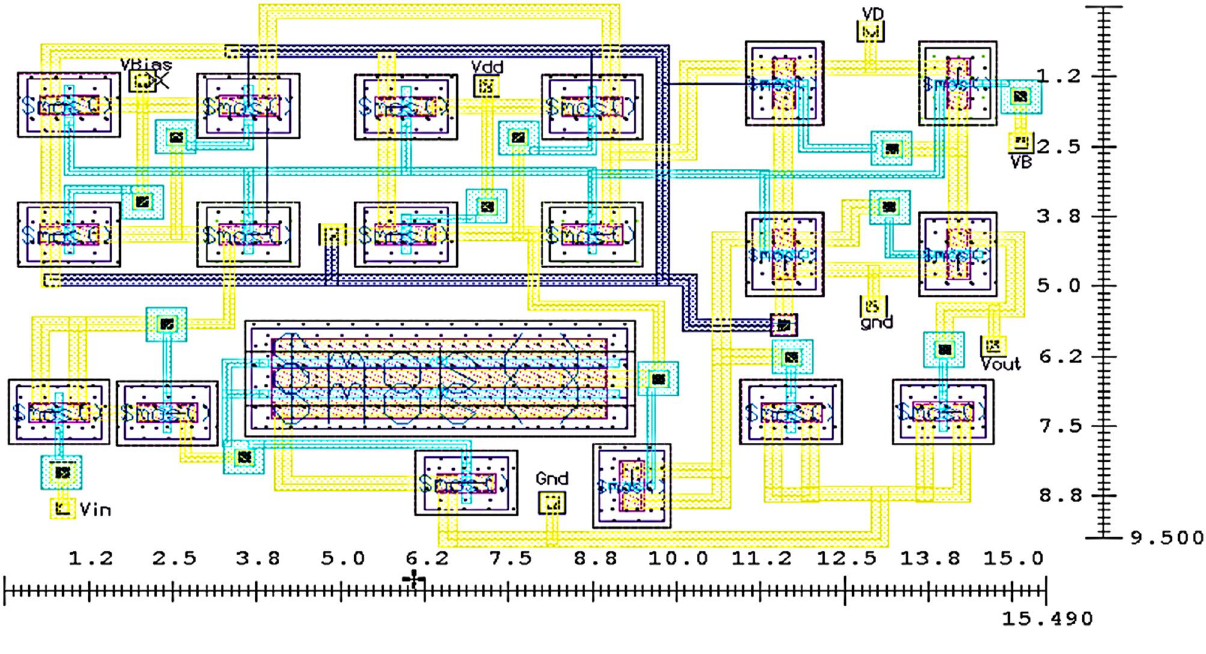
Figure 24. The core layout of Class-J PA (9.5 × 15.5) μm 2 .